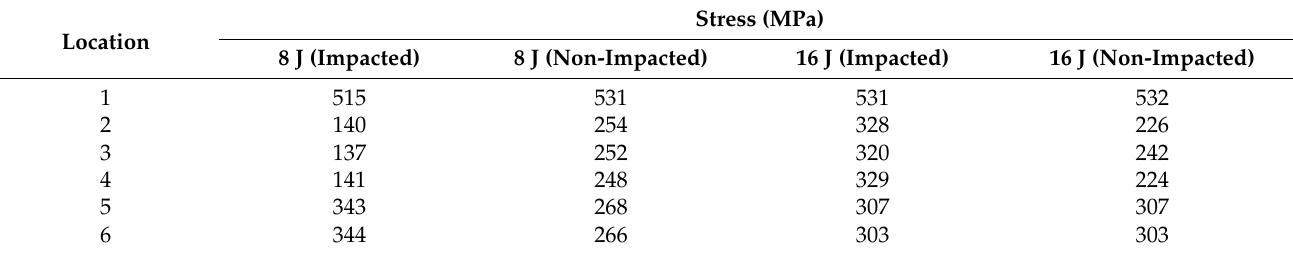
Figure 15. Detection of σ 11 on impacted and non-impacted aluminum layer of GLARE 5-2/1: ( a ) first impact: impacted aluminum layer at 16 J, ( b ) first impact: non-impacted aluminum layer at 16 J, ( c ) second impact: impacted aluminum layer at 16 J and ( d ) second impact: non-impacted aluminum layer at 16 J. Table 5. Von Mises stress on aluminum layer of GLARE 5-2/1.